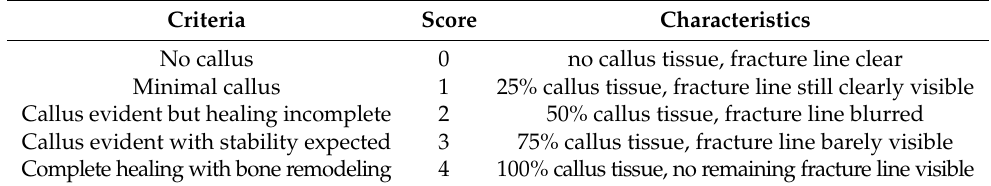
Table 1. Lane–Sandhu Scoring Criteria